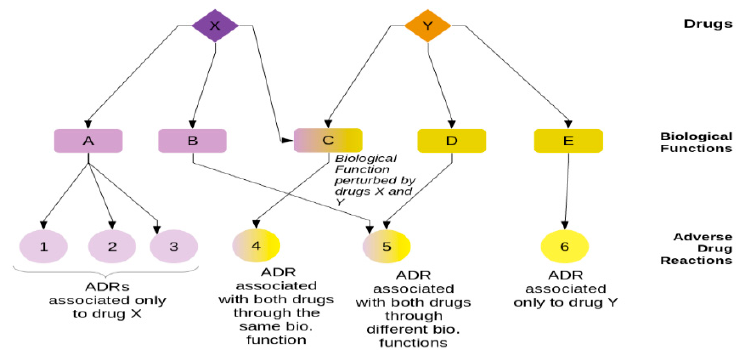
Figure 1. A diagram of three-layer (tripartite) network of drugs, biological functions, and adverse drug reactions (ADRs). This diagram includes two drugs (X and Y), where each drug may perturb biological functions. Drug X perturbs biological functions A and B, while drug Y perturbs biological functions D and E. Both drugs can also perturb function C. Each biological function perturbation may be associated with certain ADRs. Some ADRs are associated only with one drug (ADRs 1, 2, and 3 are only associated with drug X through biological function A, while ADR 6 is associated only with drug Y through biological function E). Some ADRs may be associated with both drugs. ADR 4 is associated with a function that may be perturbed by both drugs, an example of our “mode 1” model in this study. ADR 5 is associated with both drugs through different biological functions B and D, each of which is perturbed by drugs X and Y, respectively. ADR 5 is an example of our “mode 2” model in this study.